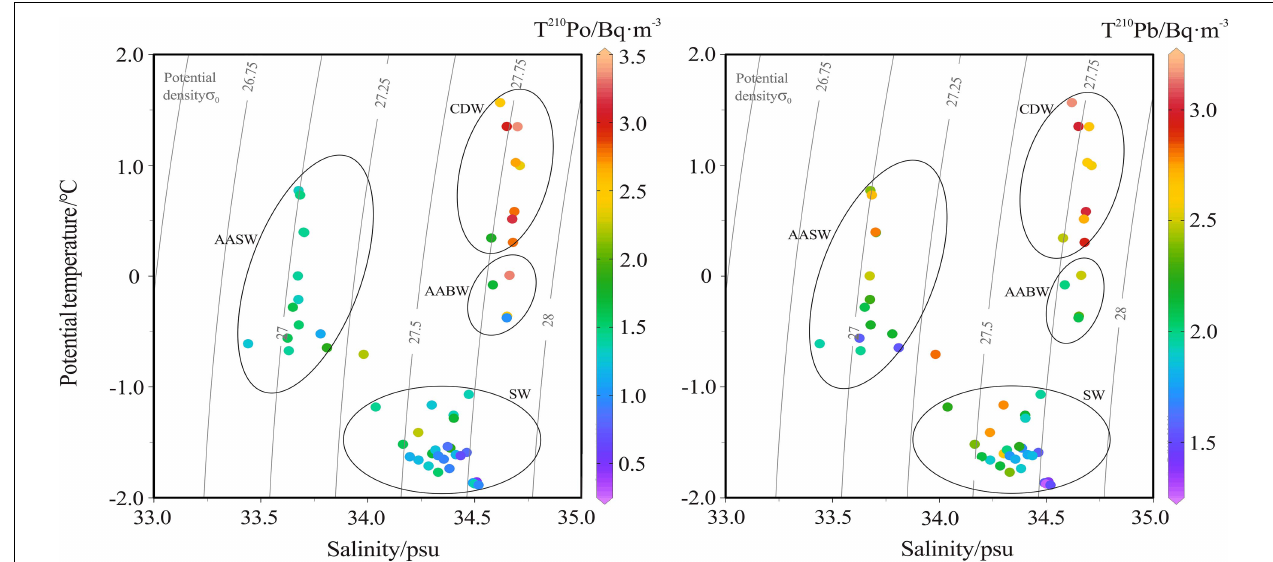
FIGURE 5 | Scatter plots of T 210 Po (left panel) and T 210 Pb activity concentration (right panel) versus potential temperature and salinity.